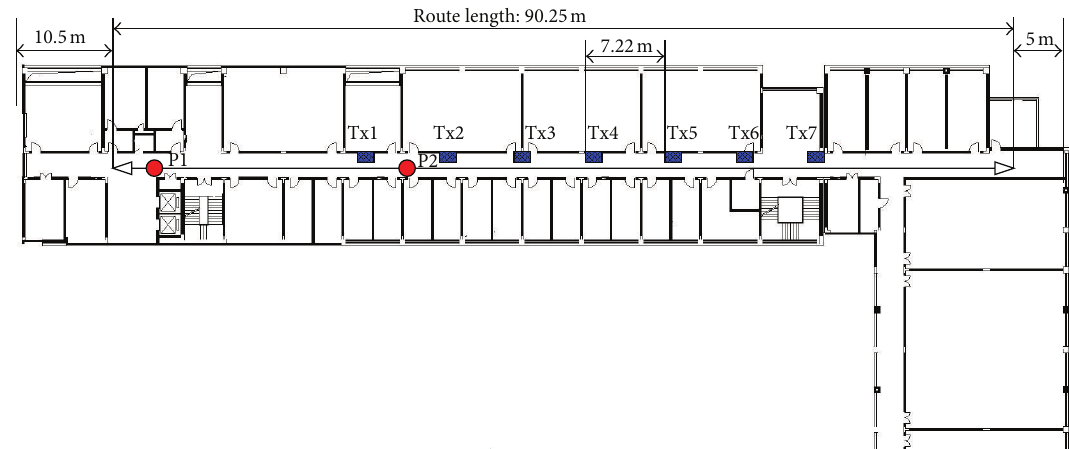
Figure 3: Floor plan of the measurement area in corridor